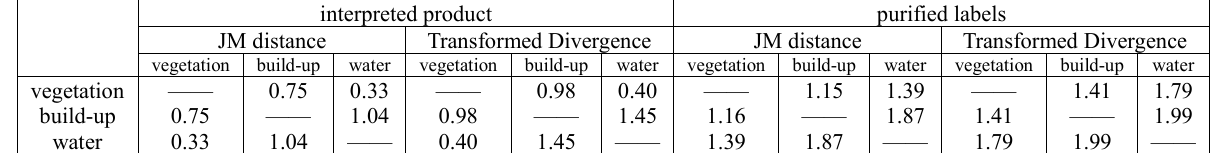
Table 4. The inter-class separability for Region 2